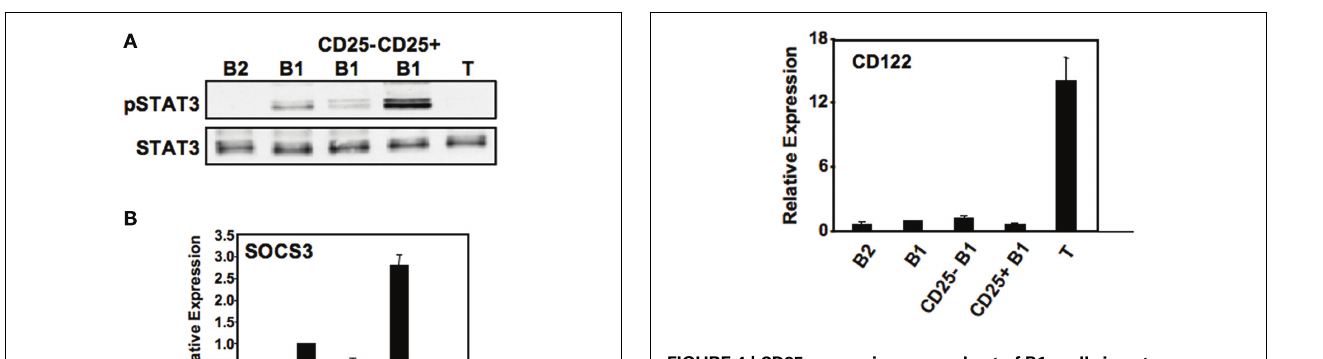
FIGURE 4 | CD25 expression on a subset of B1a cells is not accompanied by expression of CD122. Five lymphocyte populations were sort-purified: splenic follicular B2 cells (“B2”), peritoneal B1a cells (“B1”), CD25 − peritoneal B1a cells (“CD25 − B1”), CD25 + peritoneal B1a cells (“CD25 + B1”), and splenicT cells (“T”). B cell populations were unstimulated whereasT cells were stimulated by ConA at 5 μ g/ml for